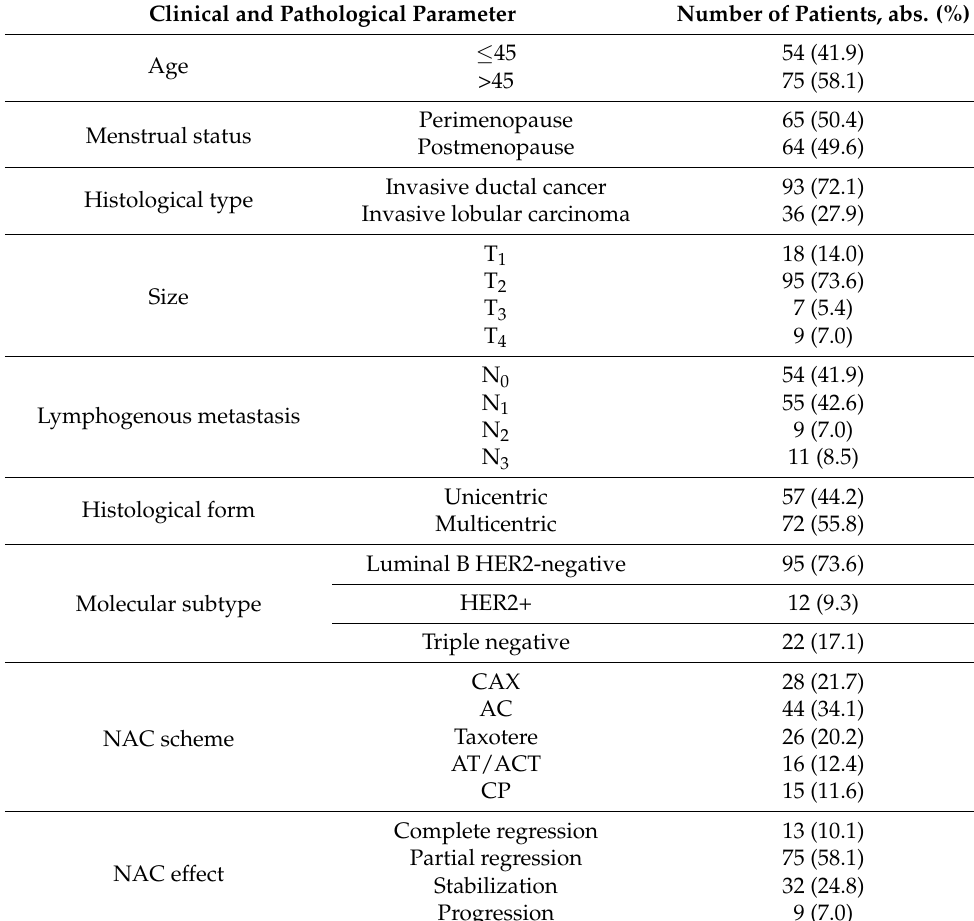
Table 1. Clinical and pathological parameters of breast cancer